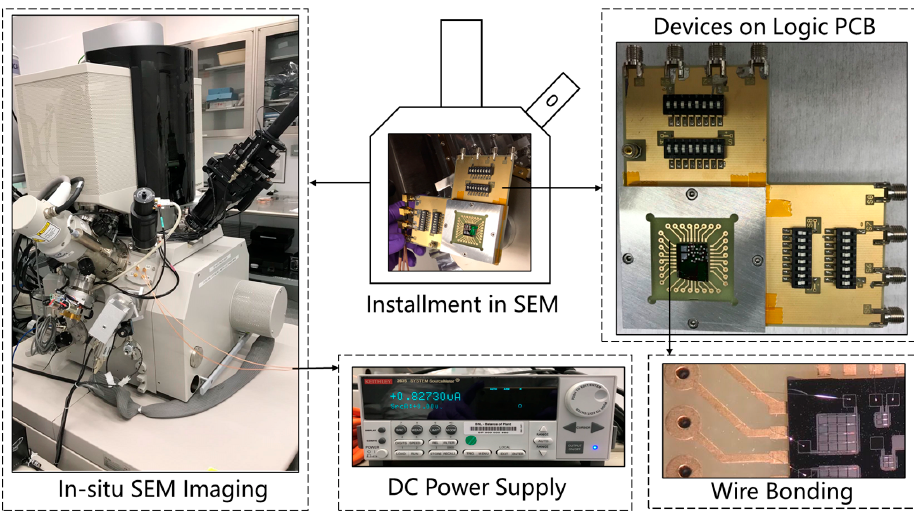
Figure 13. Experimental setup microstructures on the silicon chip for testing.